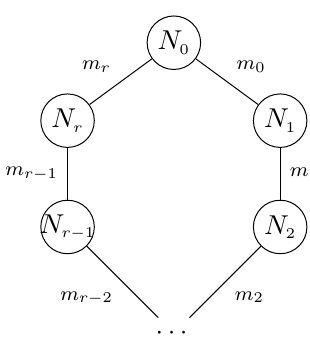
Figure 18 . Mass-deformed non-Abelian b A r extended